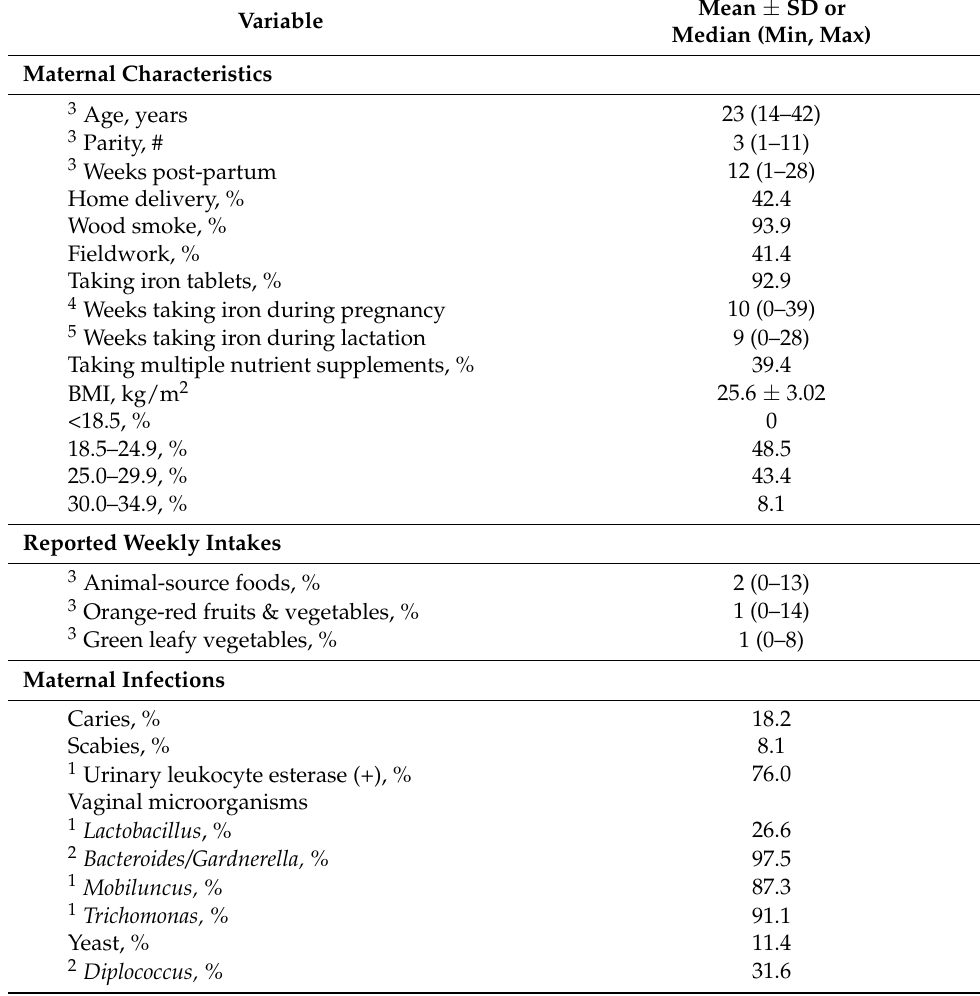
Mean ± SD or Median (Min, Max)